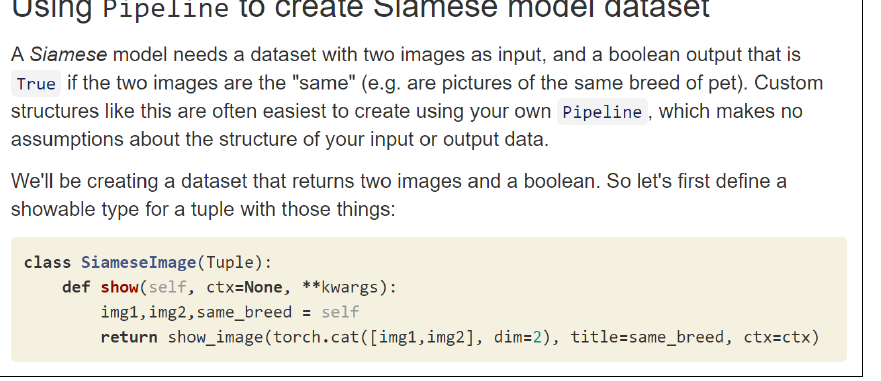
Figure 12. Example of fastai’s documentation, automatically generated using